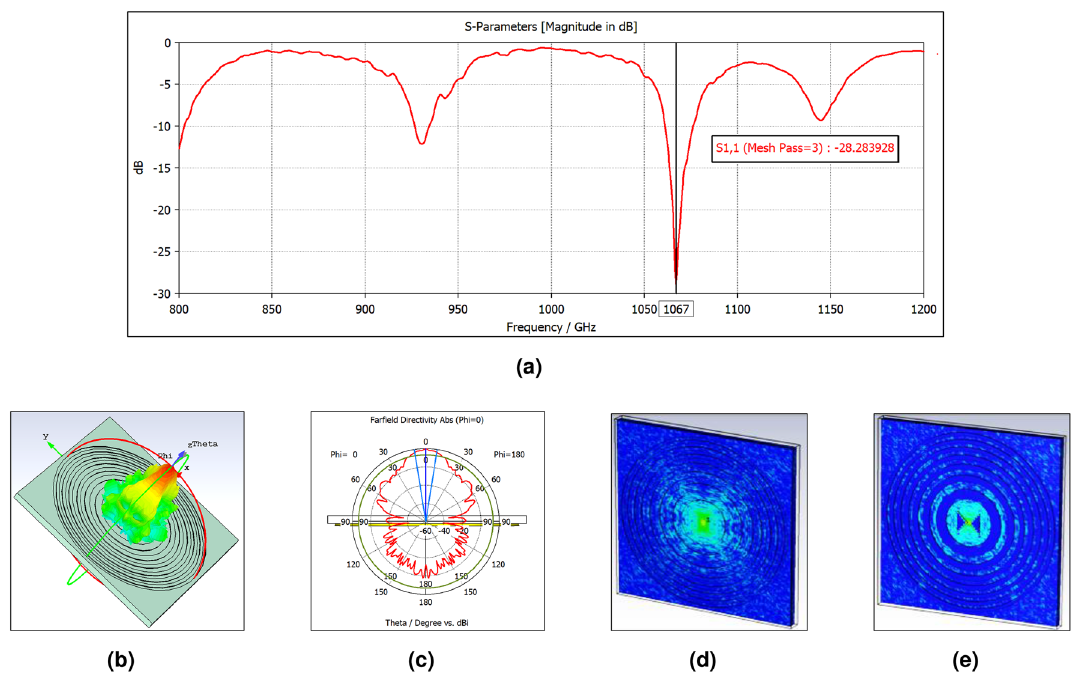
Figure 4. The CST results at 1.067 THz: ( a ) the S 11 parameter with a minimum at 1.067 THz. ( b ) The 3D far- field. ( c ) The polar chart. ( d ) The electric field distribution for the FZP’s side. ( e ) The electric field distribution for the antenna’s